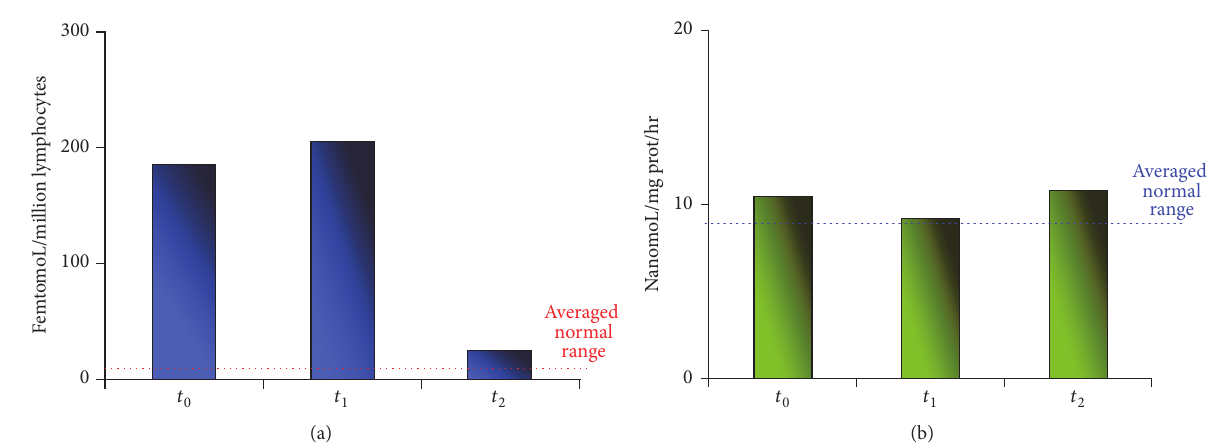
Figure 2: Measured neurochemical markers levels at admission ( 𝑡 0 ), two days after DMSA chelation challenge test ( 𝑡 1 ), and about 1 year (410 days) ( 𝑡 2 ) after the TU admission. (a) Lymphocytes muscarinic receptors (l-MRs). (b) Platelets monoamine oxidase B activity